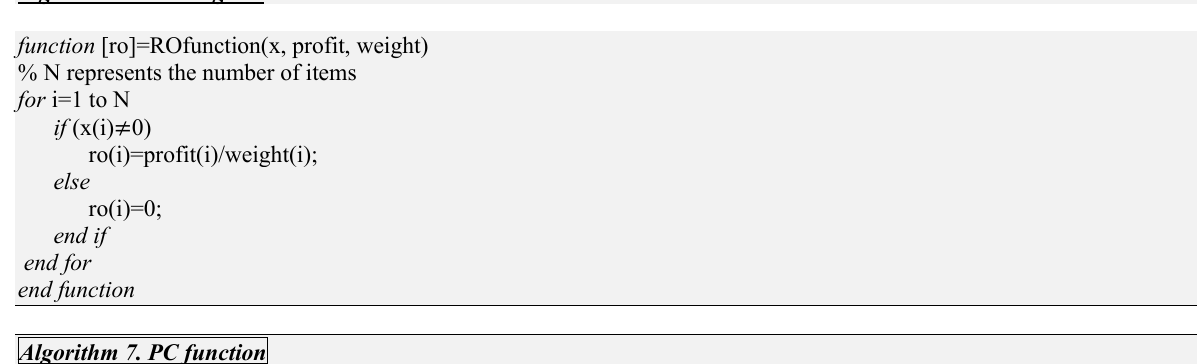
Algorithm 6. Finding RO